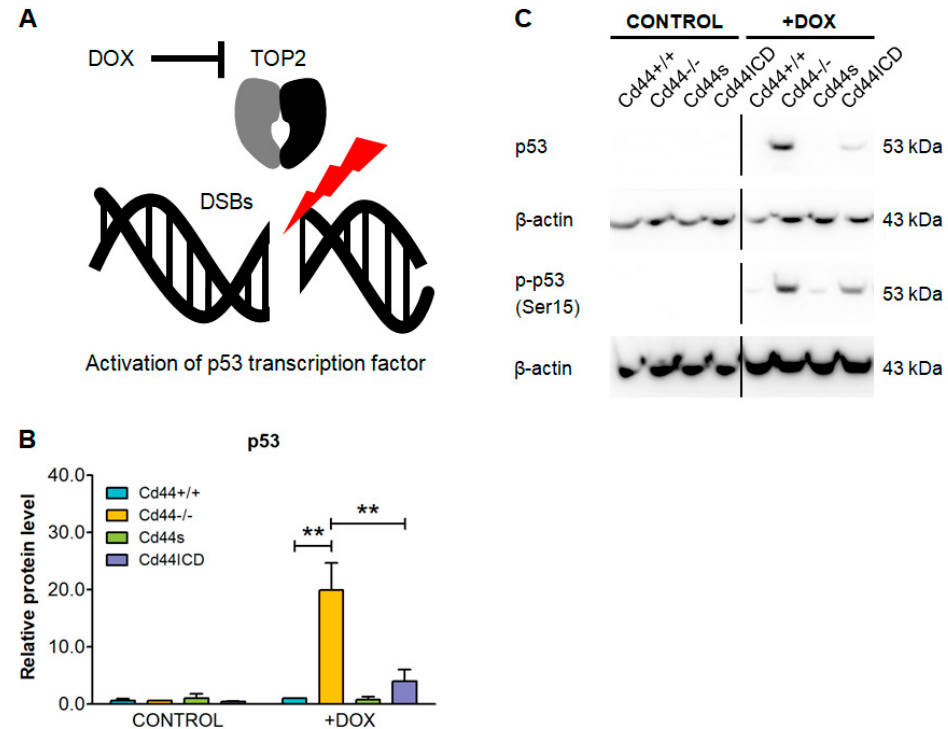
Figure 7. Testing the effect of doxorubicin (DOX) on p53 level in osteosarcoma cells. ( A ) DOX inhibits topoisomerase II (TOP2) leading to DNA damage in the form of double-strand breaks (DSBs). As a consequence, the DNA damage response and p53 pathways are activated, which leads to cell cycle arrest and cell death. ( B , C ) DOX increases levels of active p53 in Cd44 -negative osteosarcoma cells. The cells were treated as in Figure 4. The histogram in ( B ) shows mean value of p53 protein level ±SD from three independent experiments. The values were normalized to loading control. Student’s t -test values: **: p ≤ 0.01. Representative immunoblots for detection of total and phosphorylated p53 are shown in ( C ). Please notice that phosphorylated p53 was detected by reprobing lower membrane part from the experiment in Figure 4F, therefore the β -actin is the same.